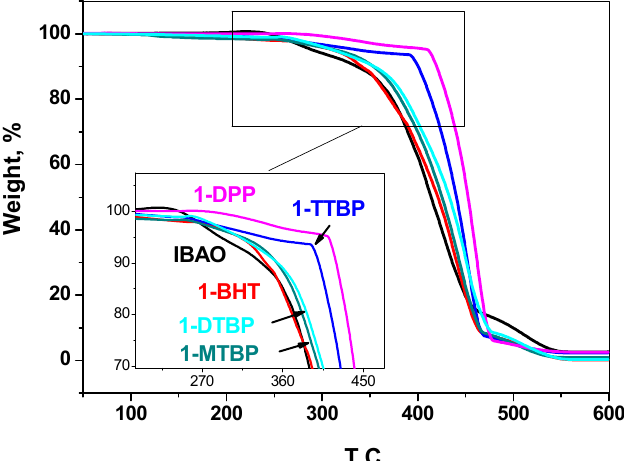
Figure 6. The effect of phenol antioxidant on thermooxidative destruction of E/P copolymers. TGA of polymers produced by rac- Et(2-MeInd) 2 ZrMe 2 /activator catalytic system, activator = IBAO (isobutylalumoxane), 1-DTBP, 1-BHT, 1-TTBP, 1-MTBP, 1-DPP. Table 4. Temperature values of mass loss in air in the range from 5 to 50% for E/P copolymers obtained with different monoaryloxide activators.